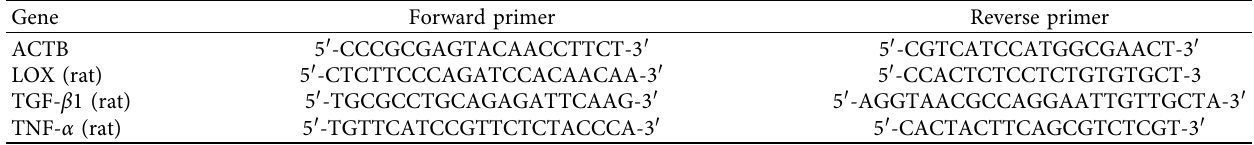
Table 1: Te primer sequences used in the RT-PCR in this study.